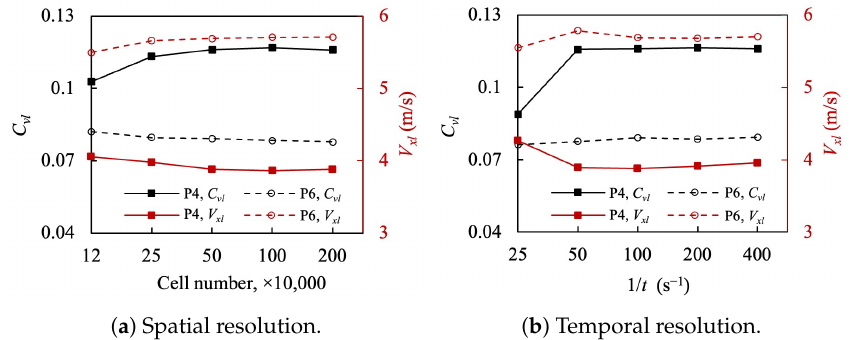
Figure 5. Convergence study of spatial and temporal resolutions.